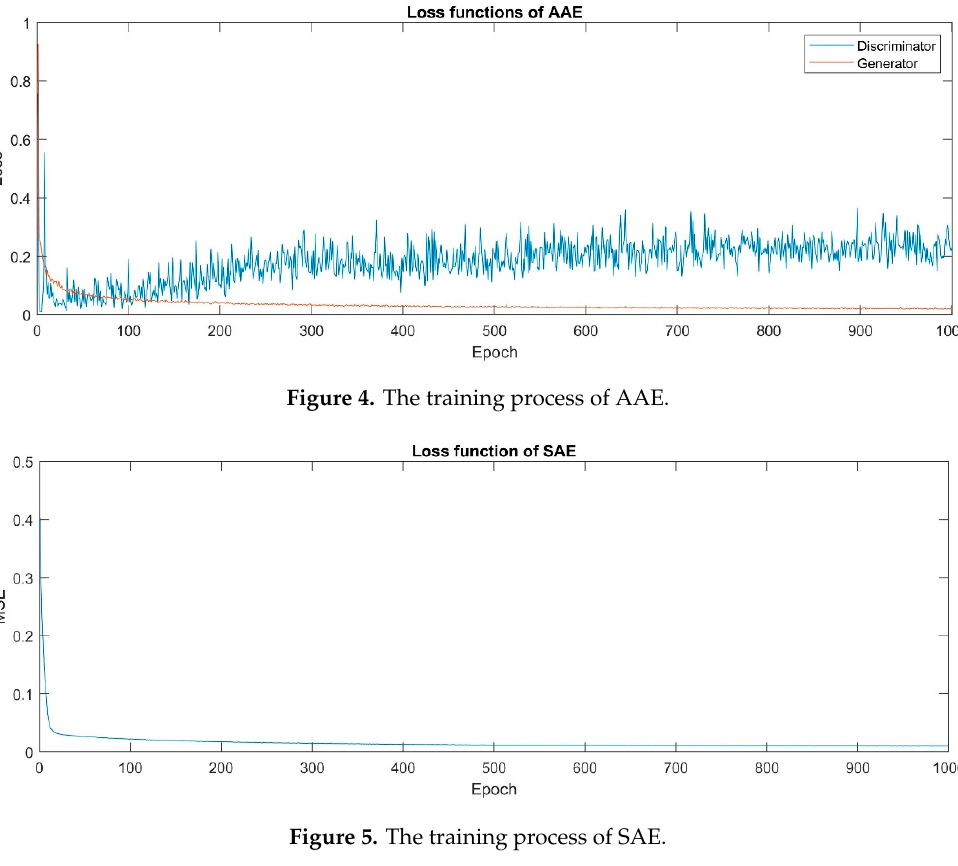
Figure 3. The training process of CAE.